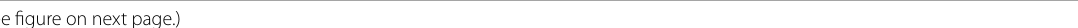
(See figure on next Fig. 1 Conventional light and confocal laser scanning microscopic (CLSM) images showing the bark structure just before the formation of new periderm (Stage 0) in Tree A in June, 2016. Light micrographs of a transverse section ( a , e ) and a radial section ( b , f ) without staining showing the cell morphology and arrangement. c , d , g , h CLSM images of the same sections of a , b , e , f after stained with fluorol yellow 088 (FY) and Congo red (CR). e – h Higher magnification images of the selected areas in a – d . White arrows indicate the innermost periderms. AP axial parenchyma cell, F phloem fiber, IB inner bark, OB outer bark, Pd phelloderm, Pg phellogen, Ph phellem, Pr periderm, Rh rhytidome, RP ray parenchyma cell, S sieve cell. The right side of each micrograph corresponds to the outer side of the tree. Scale bars 200 µm in a – d ; 50 µm in e – h =